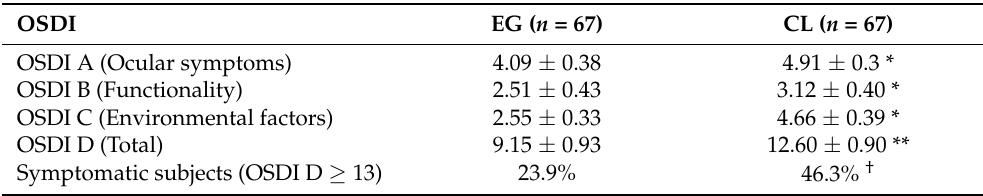
Table 2. OSDI subscale scores and total OSDI score in eye glasses (EG) wearers and soft contact lens (CL)